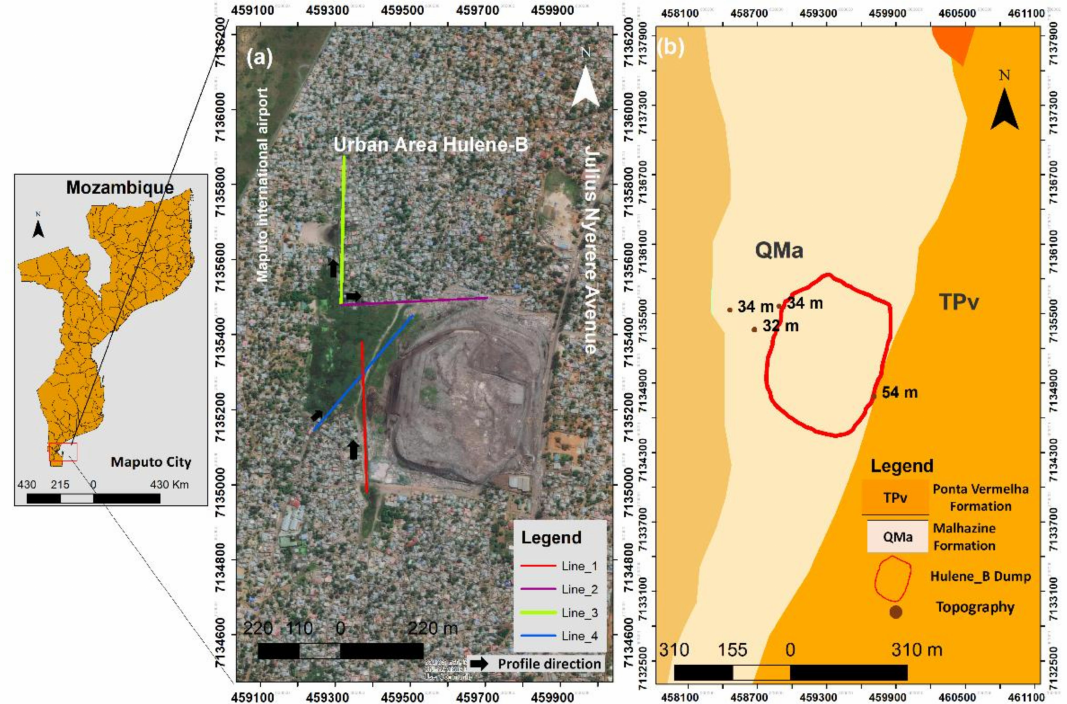
Figure 1. ( a ) Location, geophysical survey lines and environment context ( b ) geology and topography. Adapted by Oliveira et al.